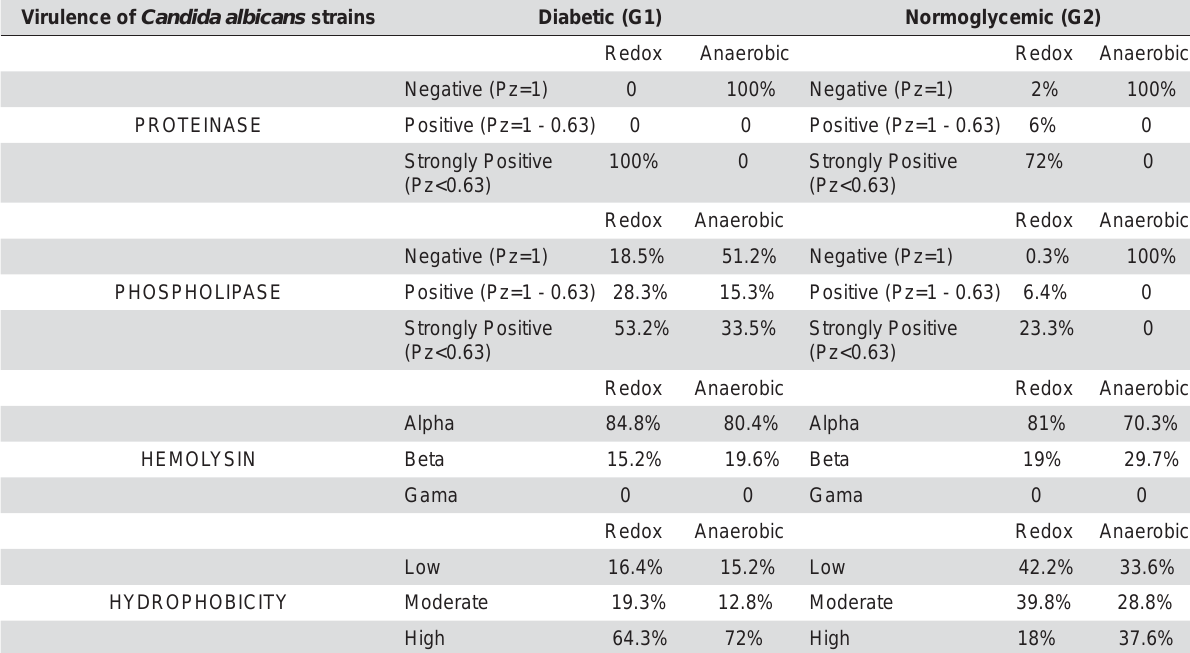
Table 2- Virulence of Candida albicans